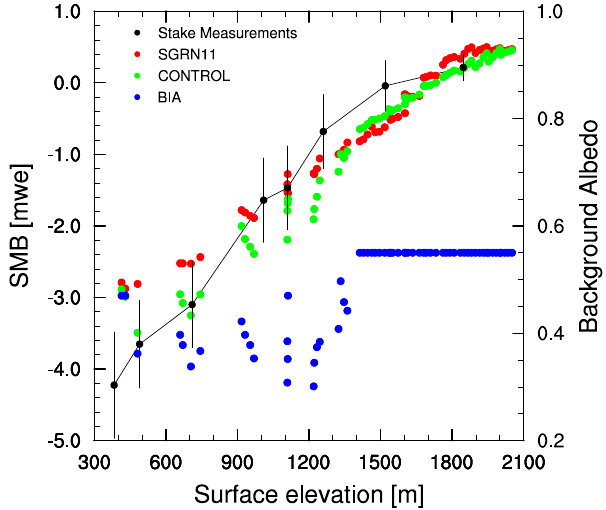
Fig. 11. Observed SMB along the K-transect for the period 1991– 2010 with two times the standard deviation of annual values as error bars (black); RACMO2 simulated SMB as a function of height for grid points in the K-transect region for the previous (red, Ettema et al., 2009) and new (green) albedo scheme. Background ice albedo values (right axis) for the corresponding grid points are also shown